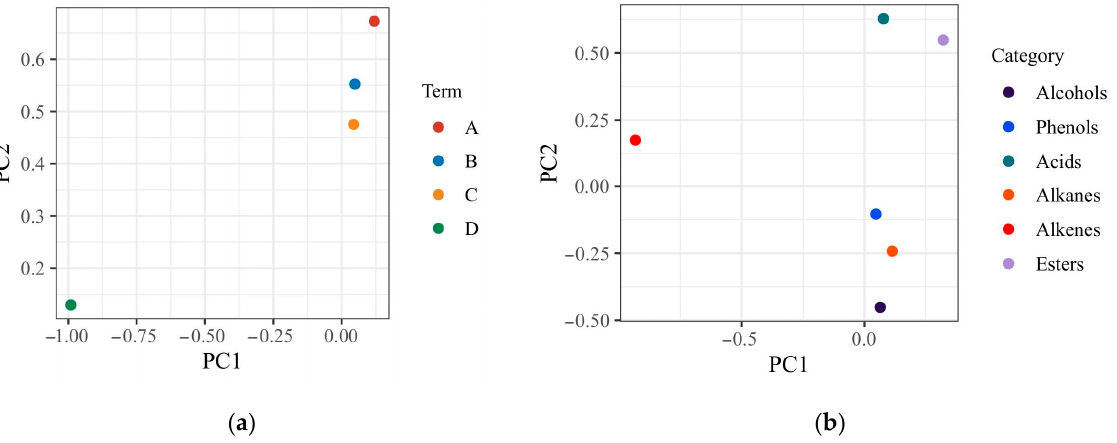
Figure 3. Principal component analysis (PCA) of 60 VOCs detected in cabya fruit during four periods of development. ( a ) Scatter plot of PCA scores for each phase; ( b ) PCA loading diagram for the types of VOCs.